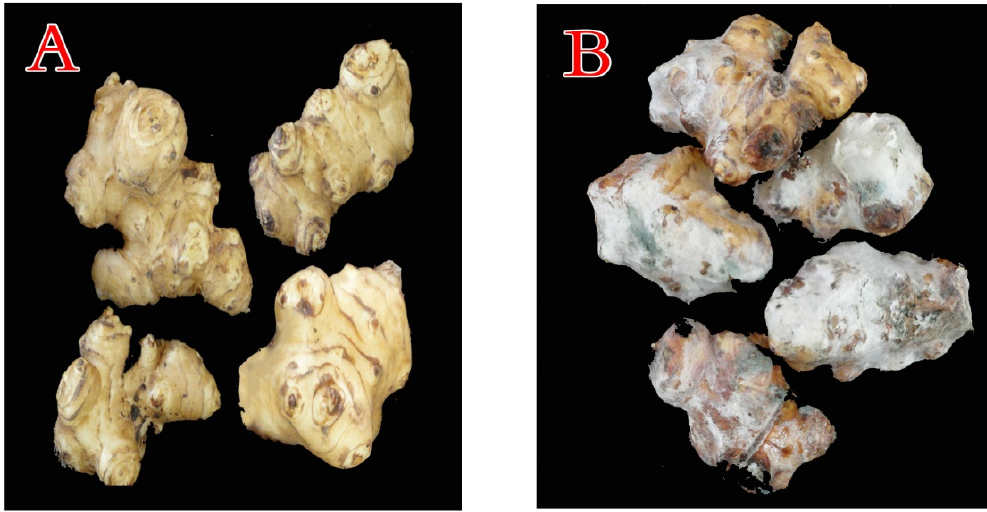
Figure 1. Tubers of Jerusalem artichoke (JA) stored under cooling conditions, showing the healthy ( A ) and blue mold decayed ( B ) tubers.